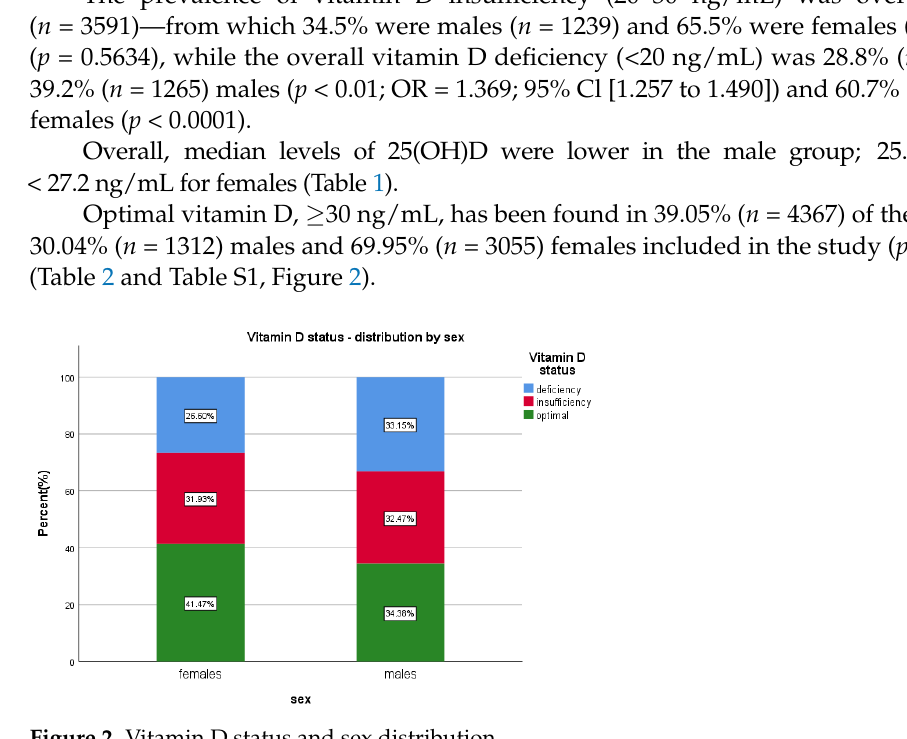
Figure 2. Vitamin D status and sex distribution. The level of 25(OH)D was not normally distributed, being skewed to the right. The median level of 25(OH)D was 26.45 ng/mL (with range 3.5–154.2), with coefficient of skewness 1.384, coefficient of kurtosis of 6.283 with the Kolmogorov–Smirnov test for nor- mality ( p < 0.01).